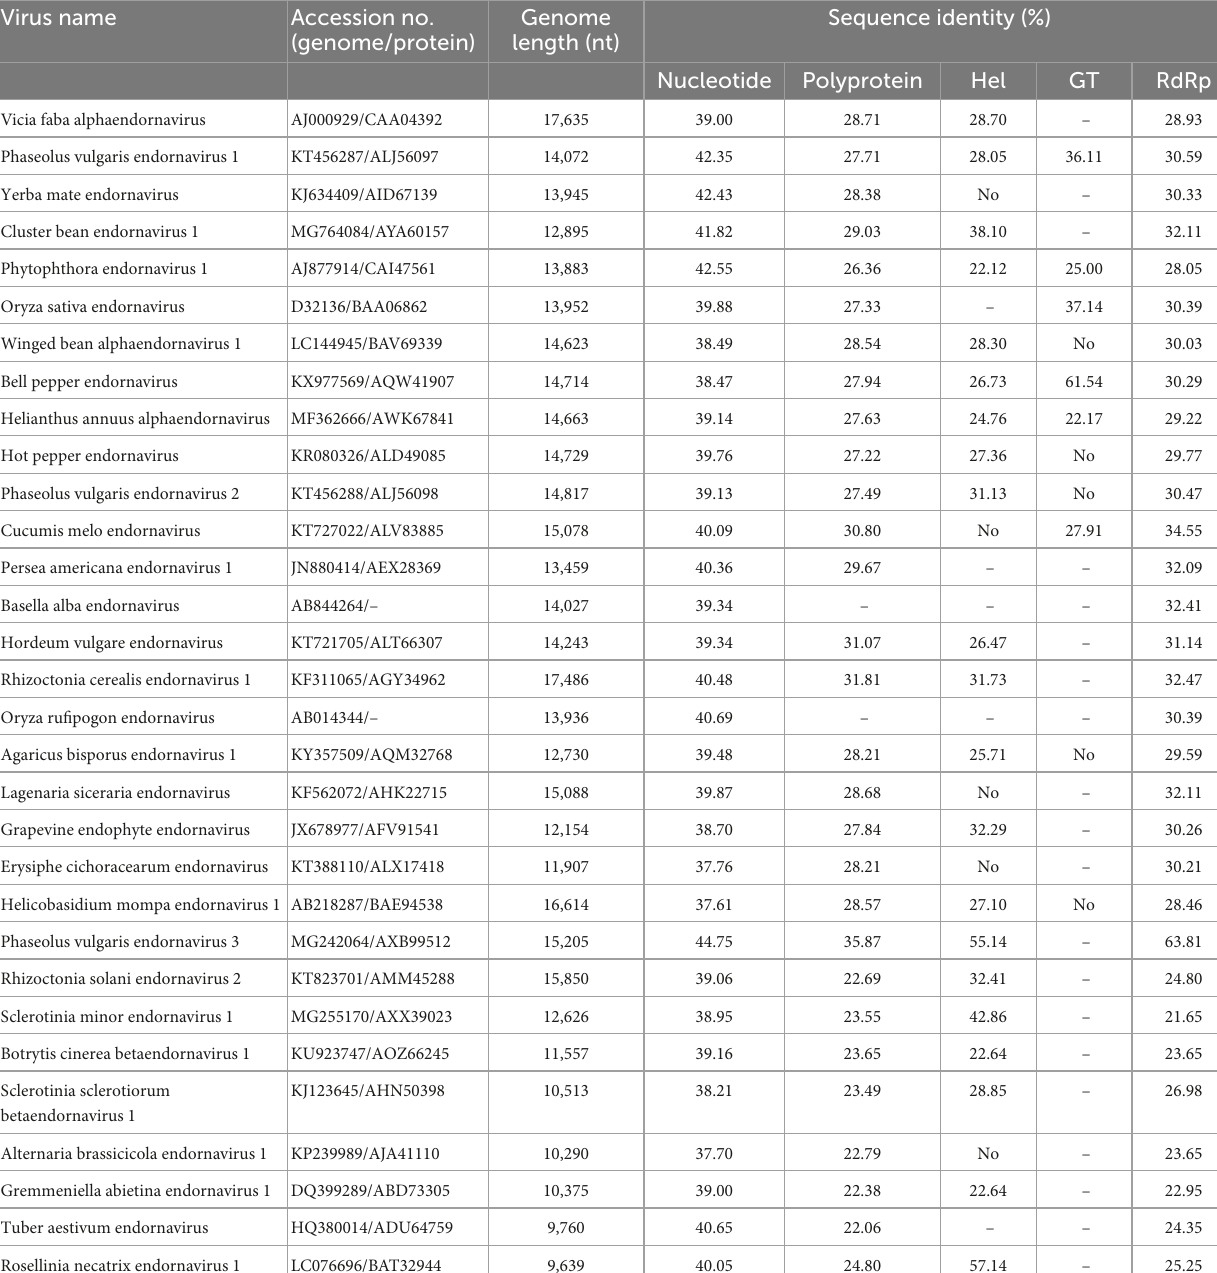
TABLE 3 Nucleotide and amino acid sequence identity values from a comparison of LaEV-1 sequences with the corresponding regions of other